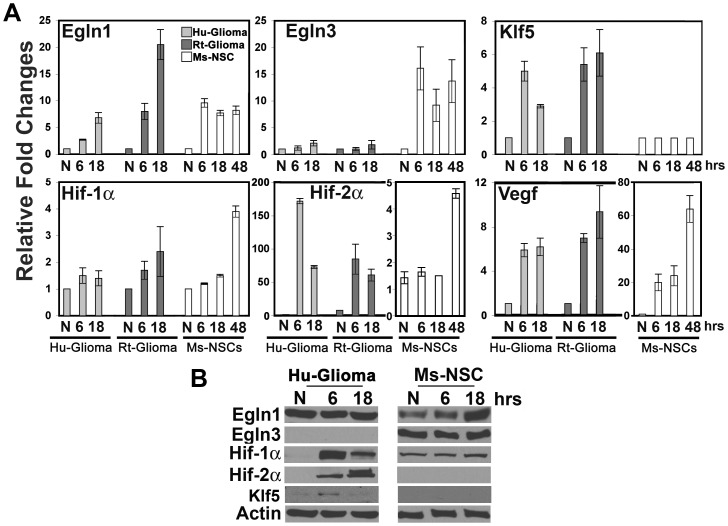
Hypoxic expression profile using an Human glioma cell model.Hu-glioma cells, Rt-glioma cells and Ms-NSCs were cultured under normoxic conditions and subjected to hypoxia for 6–48hrs, as indicated. (A) RT-QPCR was performed with primers specific for Egln1, Egln3, Klf5, Hif-1α, Hif-2α and Vegf. Data are expressed as fold changes relative to the normoxic condition for each respective cell type and normalized to β-actin mRNA. Mean values +/− s.d. are shown; n = 3. (B) Protein expression analysis of Hu-glioma cells and Ms-NSCs, as described in Figure 1.